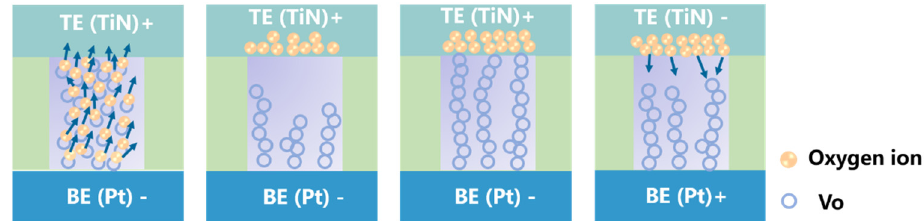
Figure 8. The schematics of the complete switching mechanism of Pt/TaO x :Al/TiN RRAM.